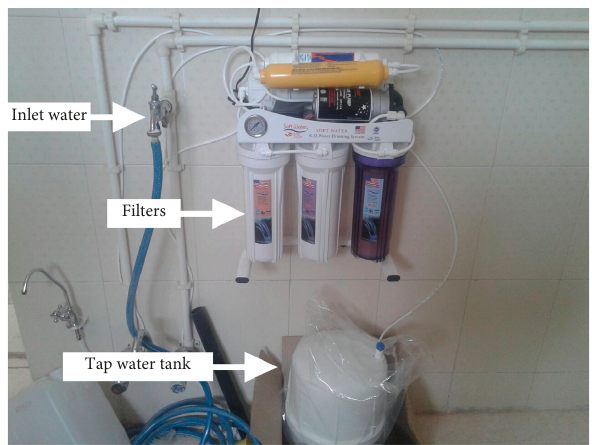
Figure 4: The water desalination system which gives the tap water output. It is working by the reverse osmosis procedure.